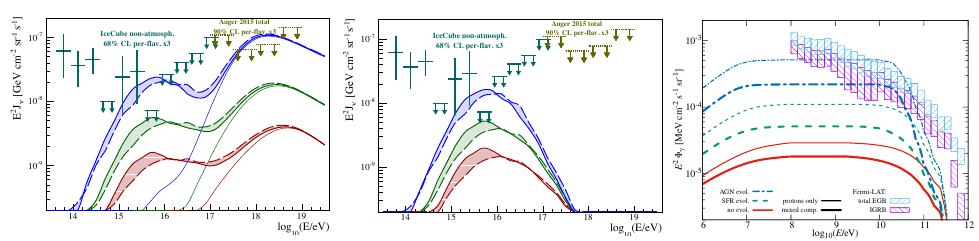
Figure 2. [Left panel] Fluxes of neutrinos in the case of a pure proton composition. The three di ff erent fluxes correspond to di ff erent assumptions on the cosmological evolution of sources (from bottom to top): no evolution (red), star formation rate evolution (green) and active galactic nuclei evolution (blue), coloured bands show the uncertainties due to the EBL model (see [1, 2] and references therein). Thin solid lines are neutrino fluxes ob- tained taking into account the sole CMB field. [Central Panel] Neutrino fluxes in the case of mixed composition, as shown in figure 1, with the same color code of left panel. Experimental points are the observations of IceCube on extra-terrestrial neutrinos [15] and the Auger limits on neutrino fluxes [16]. Figures taken from [10]. [Right Panel] Di ff use extragalactic gamma ray background expected from UHECR propagation in the two cases of a pure proton composition (thin lines) and mixed composition (thick lines) compared with Fermi-LAT observations